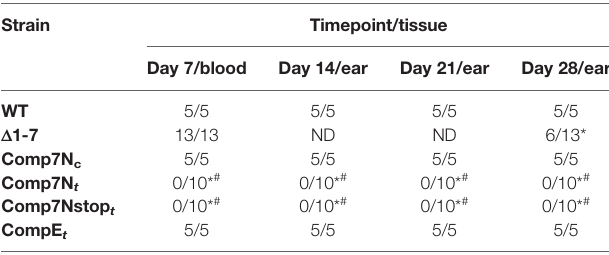
TABLE 3 | Infectivity of in trans complemented strains in C3H mice. Strain